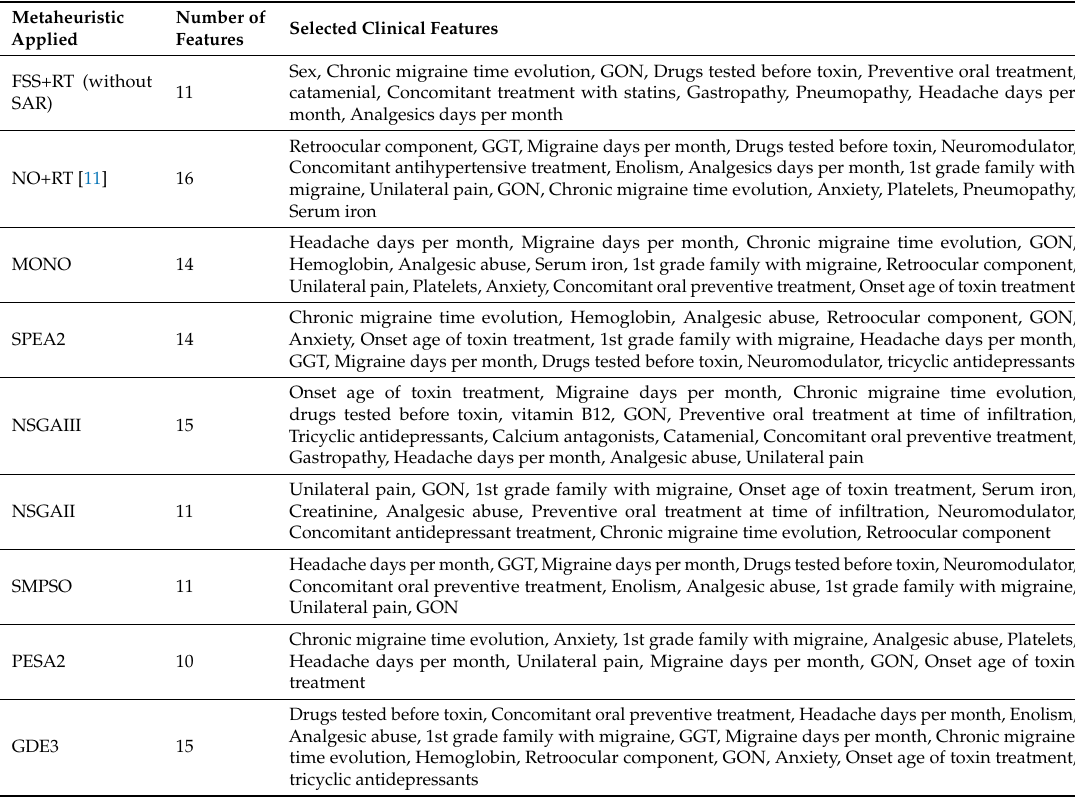
Table 6. Selected clinical features by the SOFIA method when performing multi-target prediction models with MONO and parallel